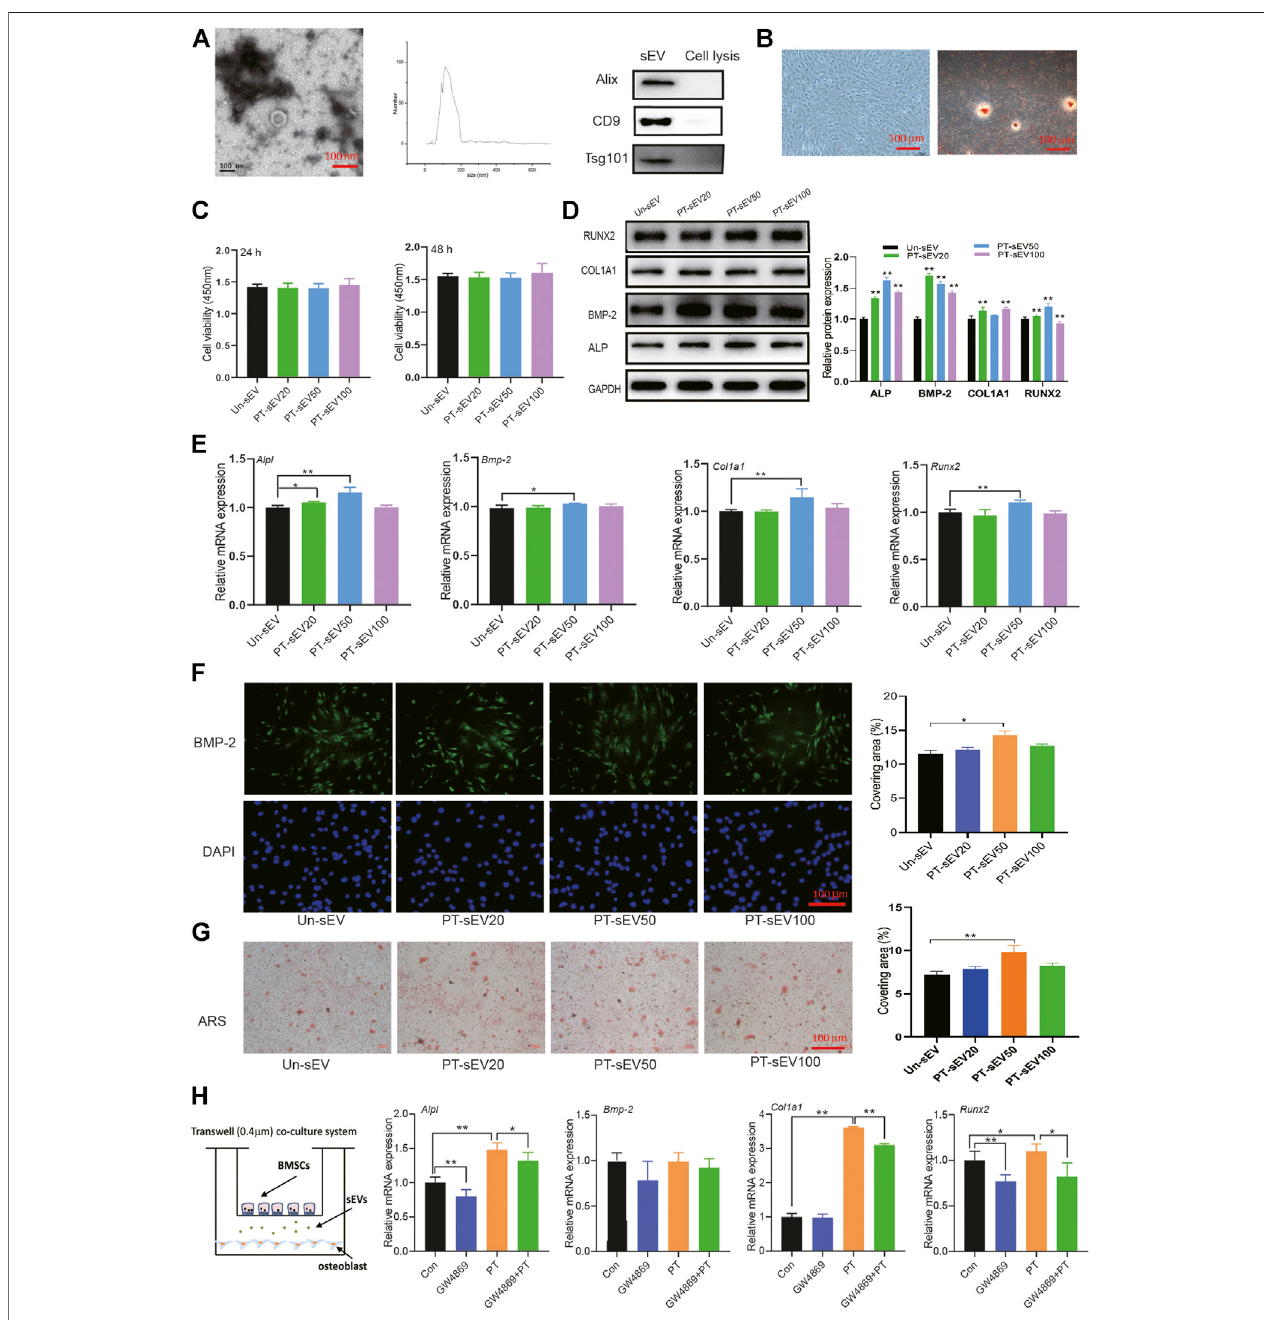
FIGURE 2 | The osteogenic effects of PT-sEV on pre-osteoblasts. (A) The identi fi cation of sEVs, including scanning electron microscope and NTA results, scale bar:100 nm; (B) Theidenti fi cationofpre-osteoblasts,includingmorphologyandalizarinredsstaining,scalebar:100 μ m; (C) TheeffectofPT-sEVonproliferationinpre- osteoblasts at 24 or 48 h, the raw data represented the mean ± SD, Un-sEV: sEVs dereived from untreated BMSCs; PT-sEV20: 20 μ g/ μ l PT-sEV, PT-sEV50: 50 μ g/ μ l PT-sEV, PT-sEV100: 100 μ g/ μ l PT-sEV (D, E) The protein and mRNA expression of osteogenic differentiation related factor treated with PT-sEV, Un-sEV: sEVs dereivedfromuntreatedBMSCs;PT-sEV20:20 μ g/ μ lPT-sEV,PT-sEV50:50 μ g/ μ lPT-sEV,PT-sEV100:100 μ g/ μ lPT-sEV,thenormalizeddatarepresentedthemean ± SD; (F) The immuno fl uorescence results of BMP-2, scale bar: 100 μ m; (G) The alizarin red s staining revealed the mineral nodules, scale bar: 100 μ m; (H) The mRNA expressionofosteogenicdifferentiationrelatedfactorundertheco-culturesystem,thenormalizeddatarepresentedthemean ± SD.* p < 0.05,** p < 0.01,analyseswere done twice and obtained comparable